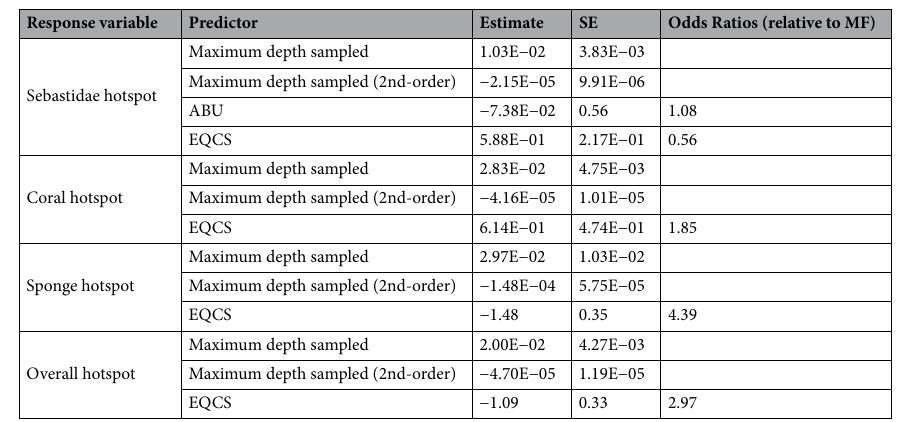
Table 3. Logistic regression results examining probabilities of hotspot occurrence within 1-km 2 planning units. Effects of Upper Ocean Subregions ( ABU Aristazabal Banks Upwelling, EQCS Eastern Queen Charlotte Sound), use Mainland Fjords (MF) as the reference. Models for corals, sponges, and overall hotspots did not include Aristazabal Banks Upwelling because no hotspots were recorded in these contexts (see Fig.